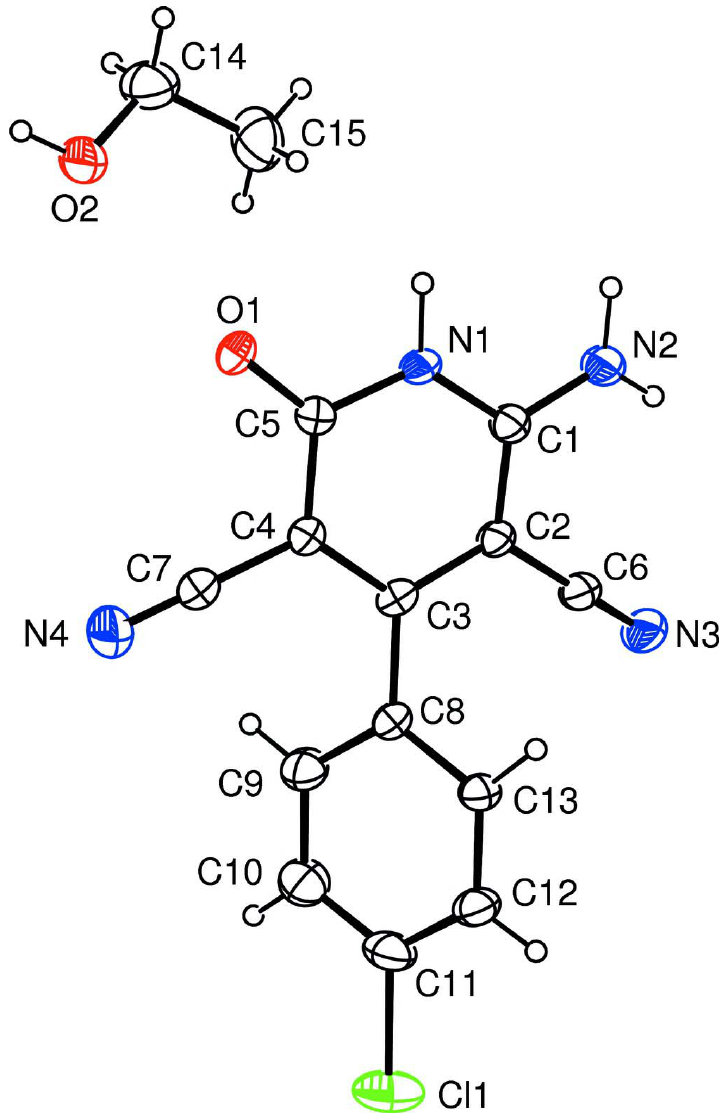
Figure 1 The molecular structure of title compound, showing 30% probability displacement